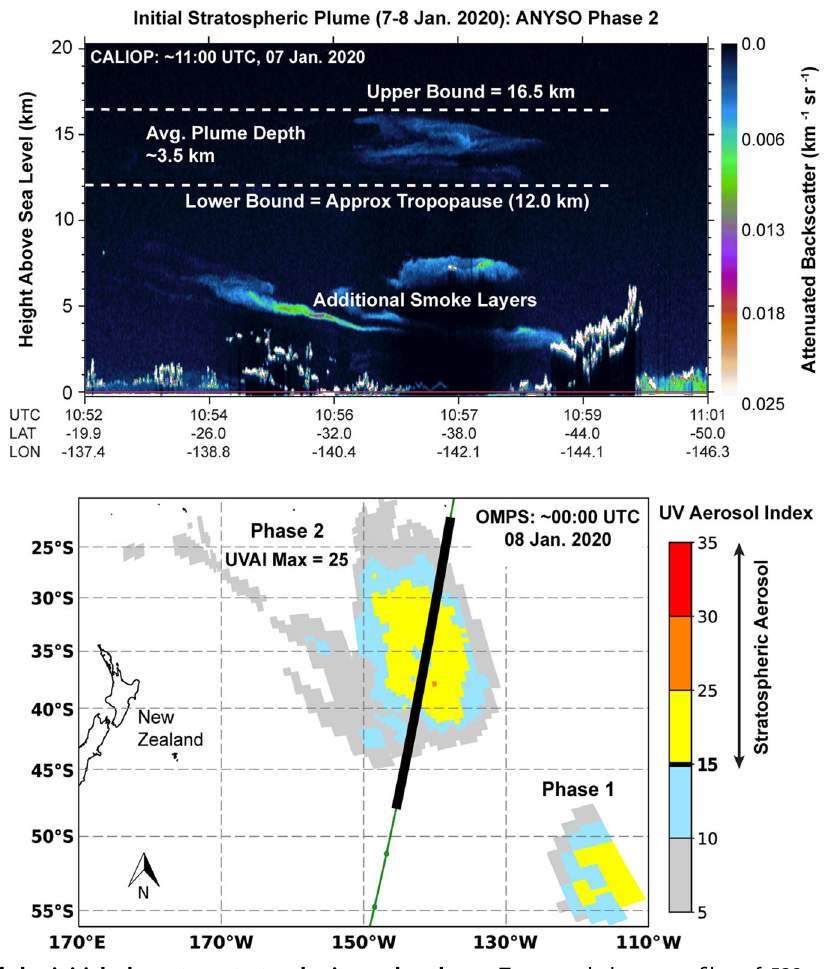
Fig. 8 Characteristics of the initial phase two stratospheric smoke plume. Top panel shows pro fi les of 532 nm attenuated backscatter (km − 1 sr − 1 ) observed by CALIOP on 07 January 2020 for a nighttime (descending) CALIPSO overpass beginning 10:52 UTC. Dashed white lines denote the approximate upper and lower bounds of the plume. Bottom panel shows ultra-violet aerosol index (UVAI) observations from OMPS on 08 January 2020 at 00:00 UTC, which is ~13 h after the CALIOP observations in the top panel. The corresponding CALIPSO satellite track is superimposed green, with black indicating the segment used above. The horizontal extent of the stratospheric smoke plume (AI ≥ 15) is displayed in shades of yellow and